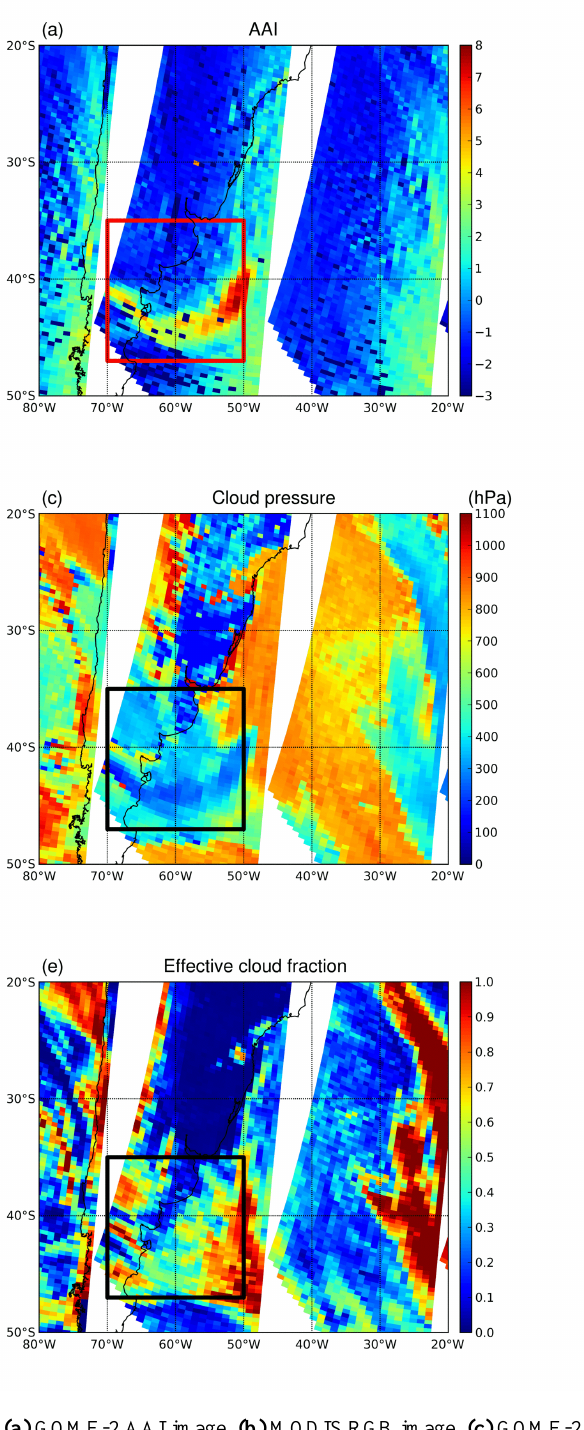
Atmos. Chem. Phys., 12, 9057–9077,